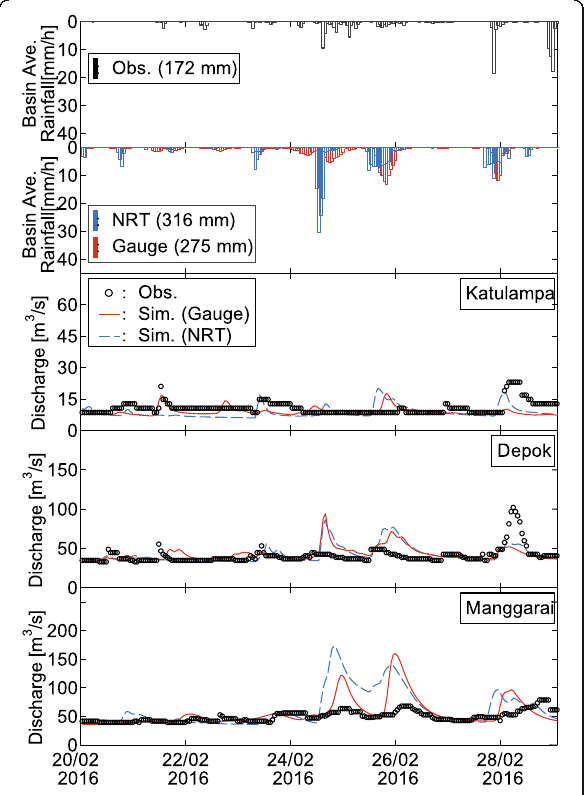
Fig. 6 Hydrograph comparisons for flood event of 2015 Fig. 7 Hydrograph comparisons for flood event of